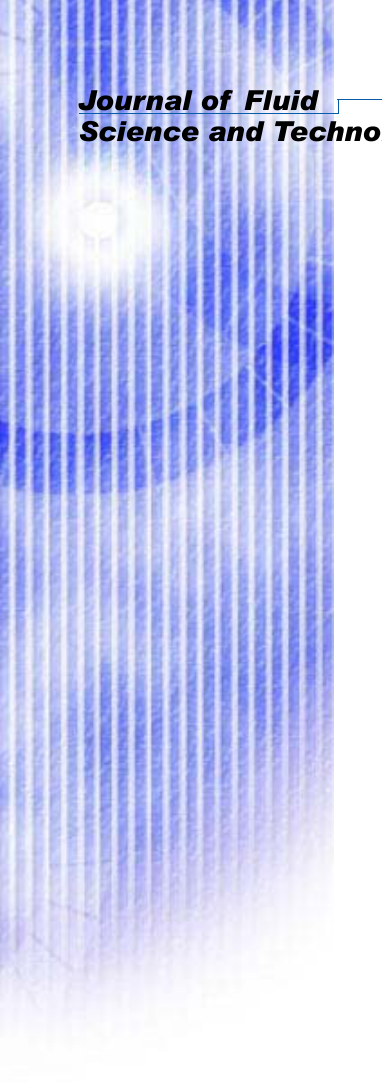
Photo of wall-shear stress